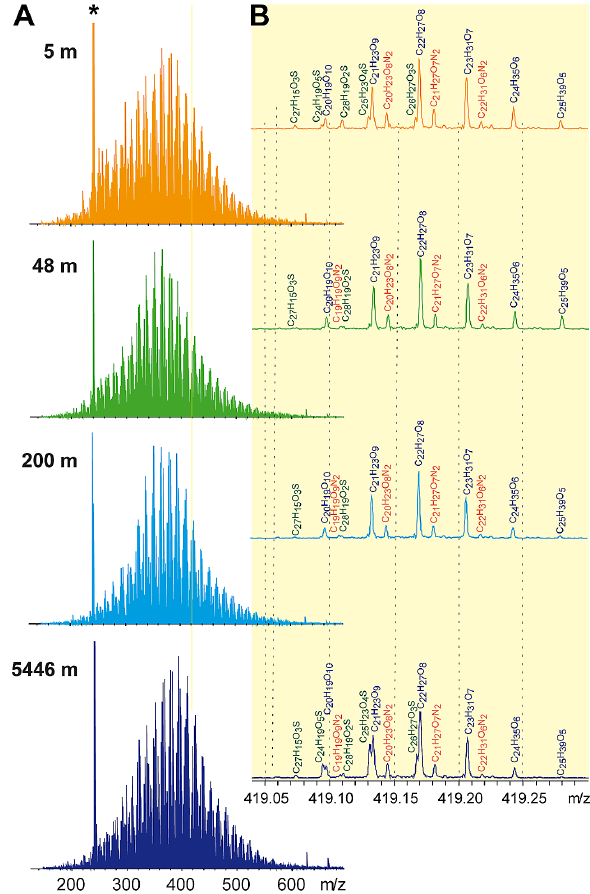
Fig. 15. Positive electrospray 12TFTICR mass spectra of marine SPE-DOM samples; from top to bottom: 5m (near-surface photic zone); 48m (fluorescence maximum); 200m (upper mesopelagic zone); 5446m (abyssopelagic, 30m above seafloor). (A) FTICR mass spectra from 150–700Da; (B) expansion of nominal mass 419 for positive ions MH + ( 1m : 419.04–419.31Da) with molecular formulae provided on the basis of their mass accuracy and mass res- olution (cf. text). Asterisk: m/z = 240 . 1495: C 15 H 18 N 3 , unknown